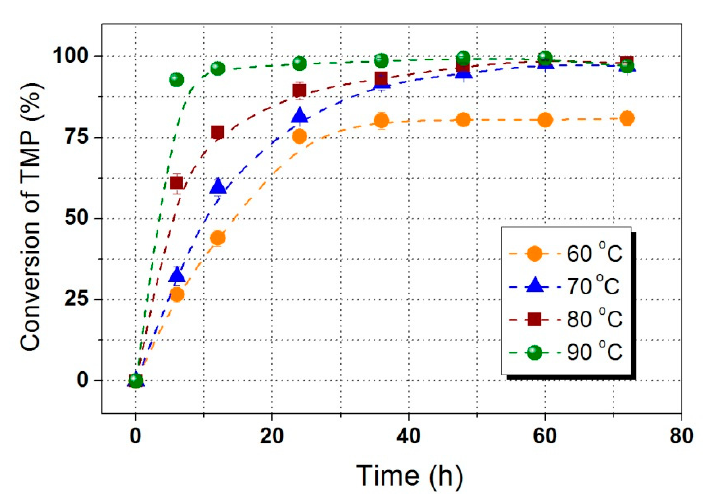
Figure 2. E ff ects of reaction temperature on the synthesis of TMP-tri-LA ester.